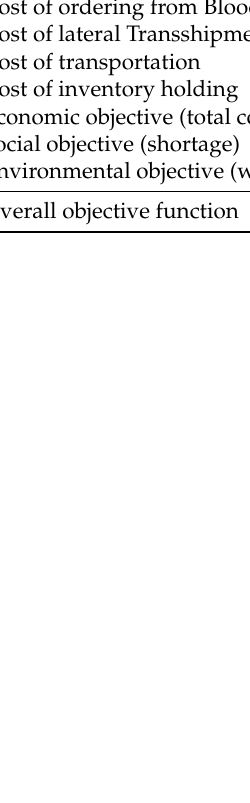
Figure 5. Convergence of the different methods in terms of the objective function versus iteration.